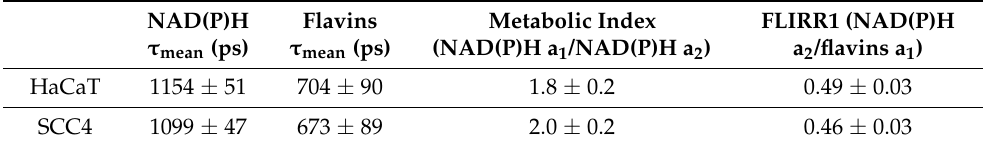
Figure 5. Intracellular distribution of the metabolic index and the redox ratio FLIRR1 within co- cultured HaCaT and SCC4 cells. Scale bar 20 µm.